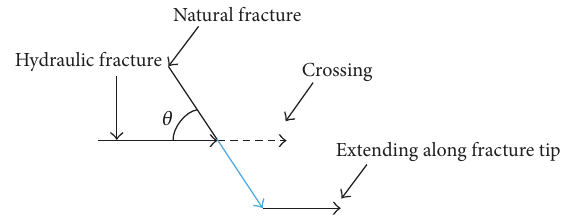
Figure 10: Diagram of hydraulic fracture reorienting propagation from natural fracture tip.